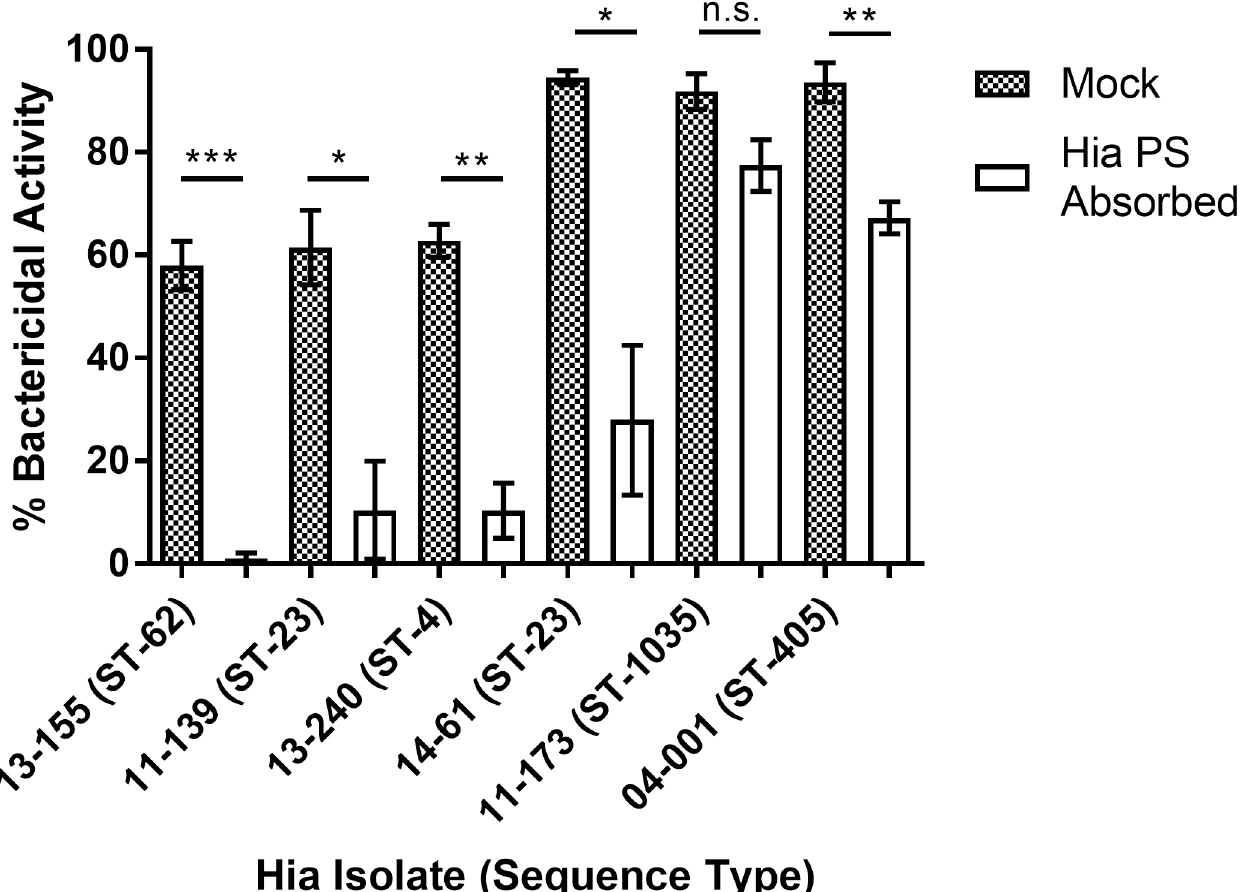
Fig 3. Hia serum sensitivity following Hia polysaccharide (PS) absorption. Absorption of anti-Hia PS antibodies from pooled serum reduced serum sensitivity of Hia isolates. Isolates were incubated with mock-absorbed or Hia PS absorbed sera (12.5%) for 1 hour at 37 o C and then viable bacteria were enumerated. Bars indicate mean percent bacterial killing determined by comparing viable bacteria following serum treatment versus heat inactivated serum ±SEM. Statistical significance was determined using Student’s two tailed t-test. (cid:3) P < 0.05; (cid:3)(cid:3) P < 0.01; (cid:3)(cid:3)(cid:3) P < 0.001; (n.s.), not significant. The graph is representative of three independent experiments, each performed in triplicate, which gave similar